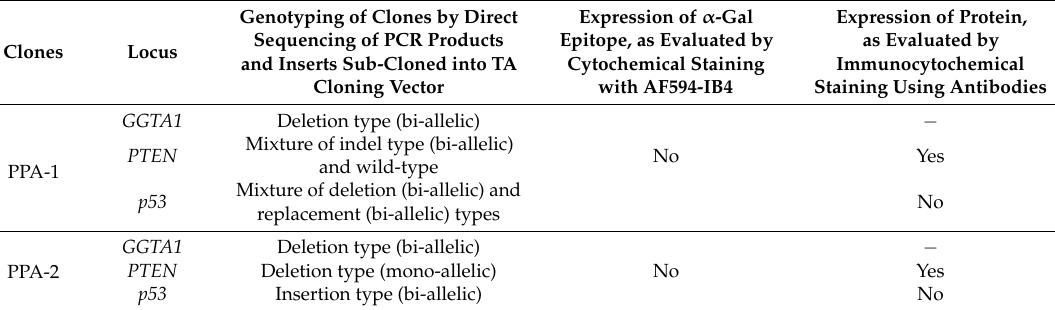
Table 3. Characterization of MPEF clones, PPA-1 and -2, after transfection and subsequent selection with